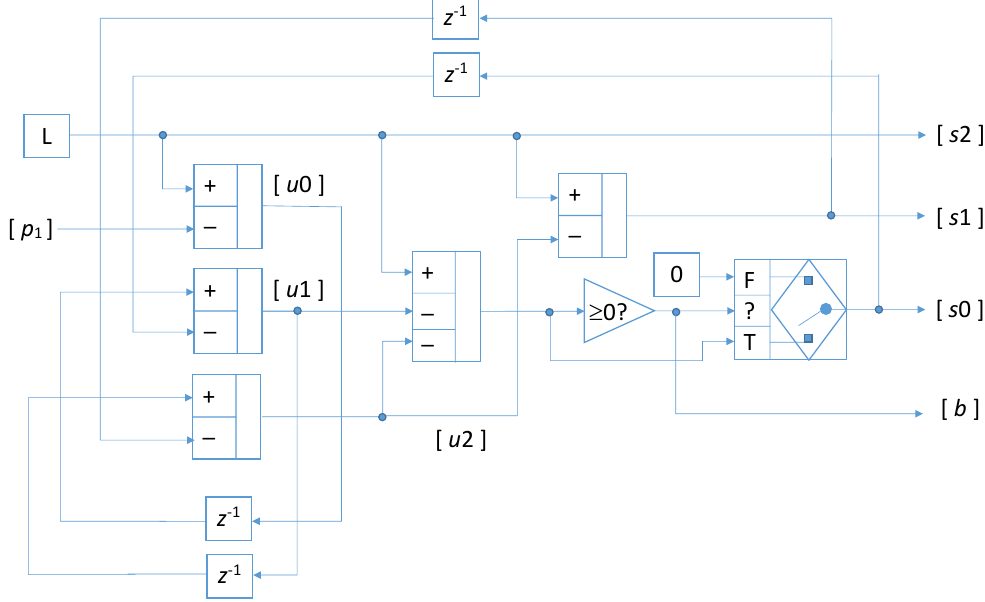
Figure 6. Block diagram illustrating the computations needed to determine the couples of triples { u 0, u 1, u 2} and { s 0, s 1, s 2}; the input to the circuit is p 1